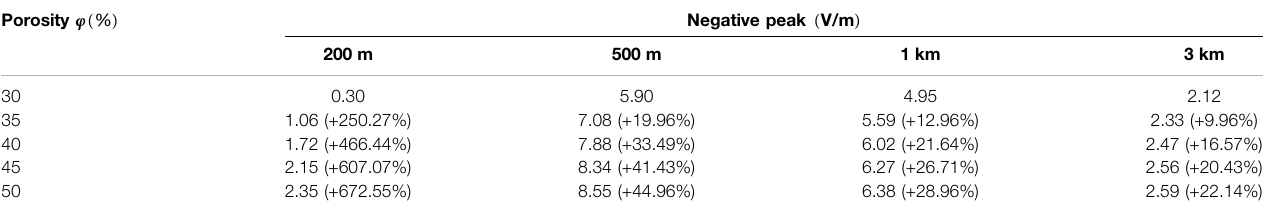
TABLE 7 | Same as Table 6 but for negative peak values of the horizontal electric fi eld for different porosities φ at different distances d (cid:2) 200m, 500m, 1km, and 3km from the lightning channel. Porosity φ ( %